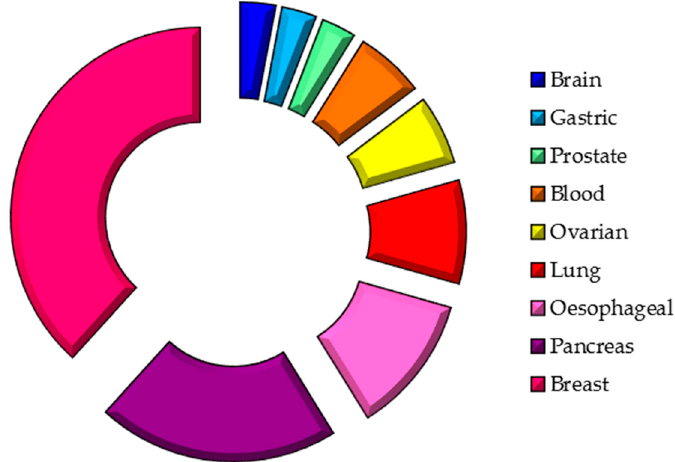
Figure 1. Salivary biomarker—sites of origin.